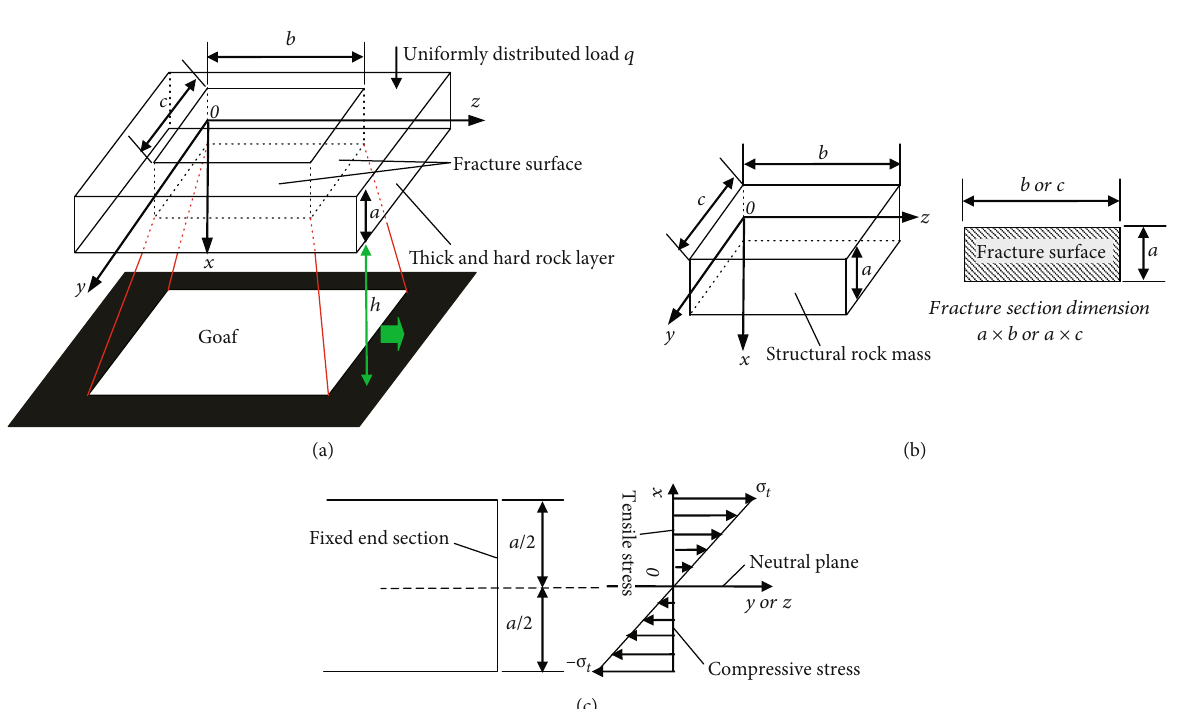
Figure 4: Schematic diagram of energy analysis in the mine quake of thick and hard rock layer type fracture. (a) Spatial structure of thick and hard rock layer in stope; (b) Structural rock mass and fracture section scale; (c) Stress characteristics of fi xed support end in the thick and hard rock